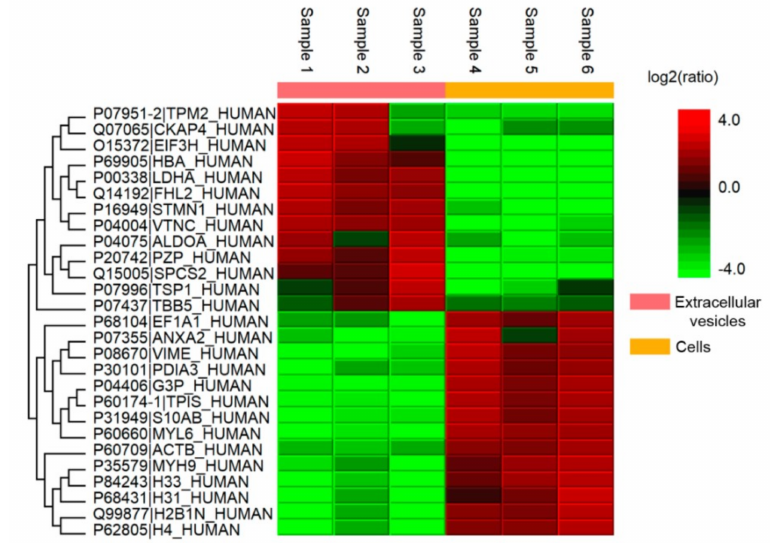
Figure 6. Hierarchical clustering based on label-free comparative analysis of protein expression levels for MSCs and